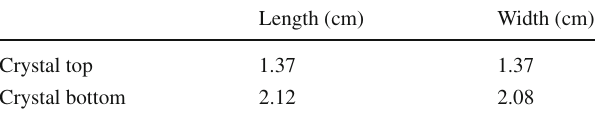
Table 1 The dimensions of the planar PPC Ge detector, USD-W06, fabricated at USD in this